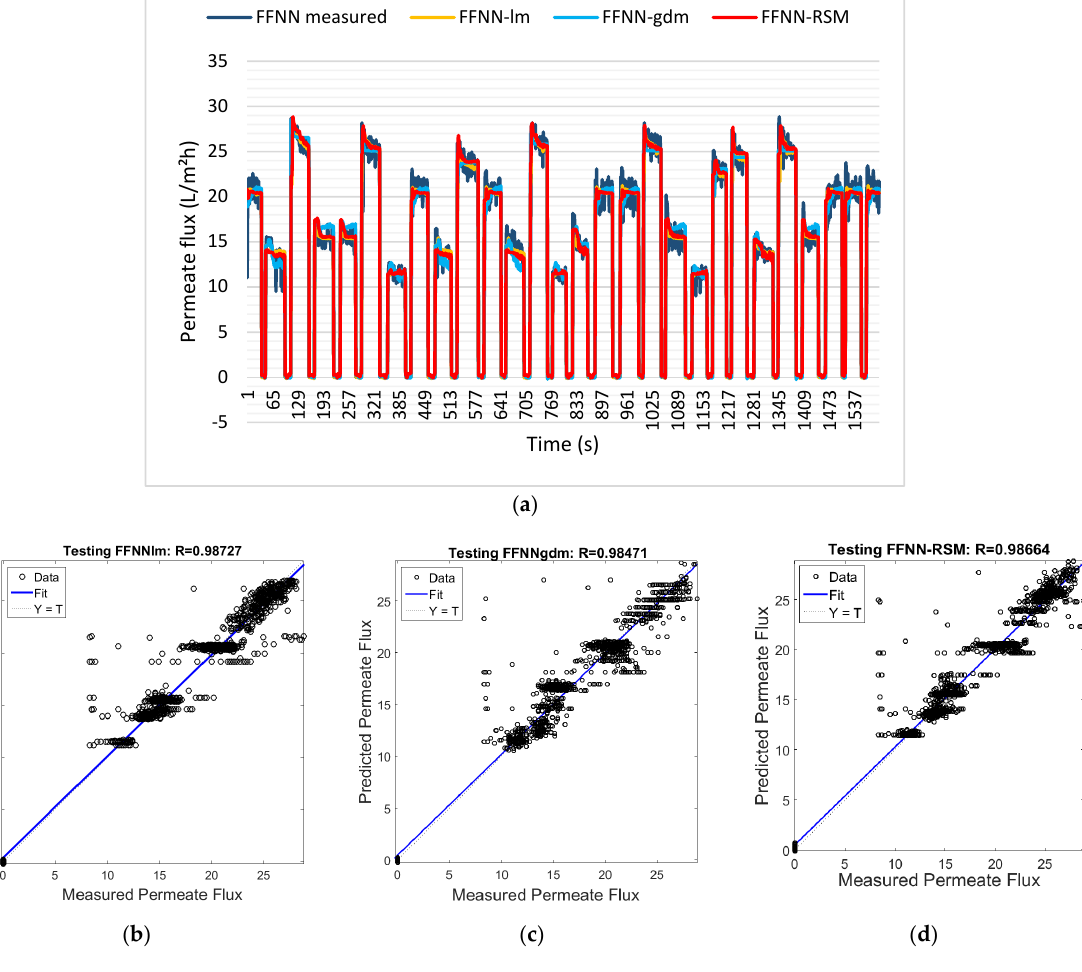
Figure 12. (a) Permeate flux for FFNN − measured, FFNN − lm, FFNN − gdm, and FFNN − RSM models. Comparison of the measured and predicted permeate flux of POME between ( b ) FFNN − lm, ( c ) FFNN − gdm, and ( d ) FFNN − RSM for the testing dataset.